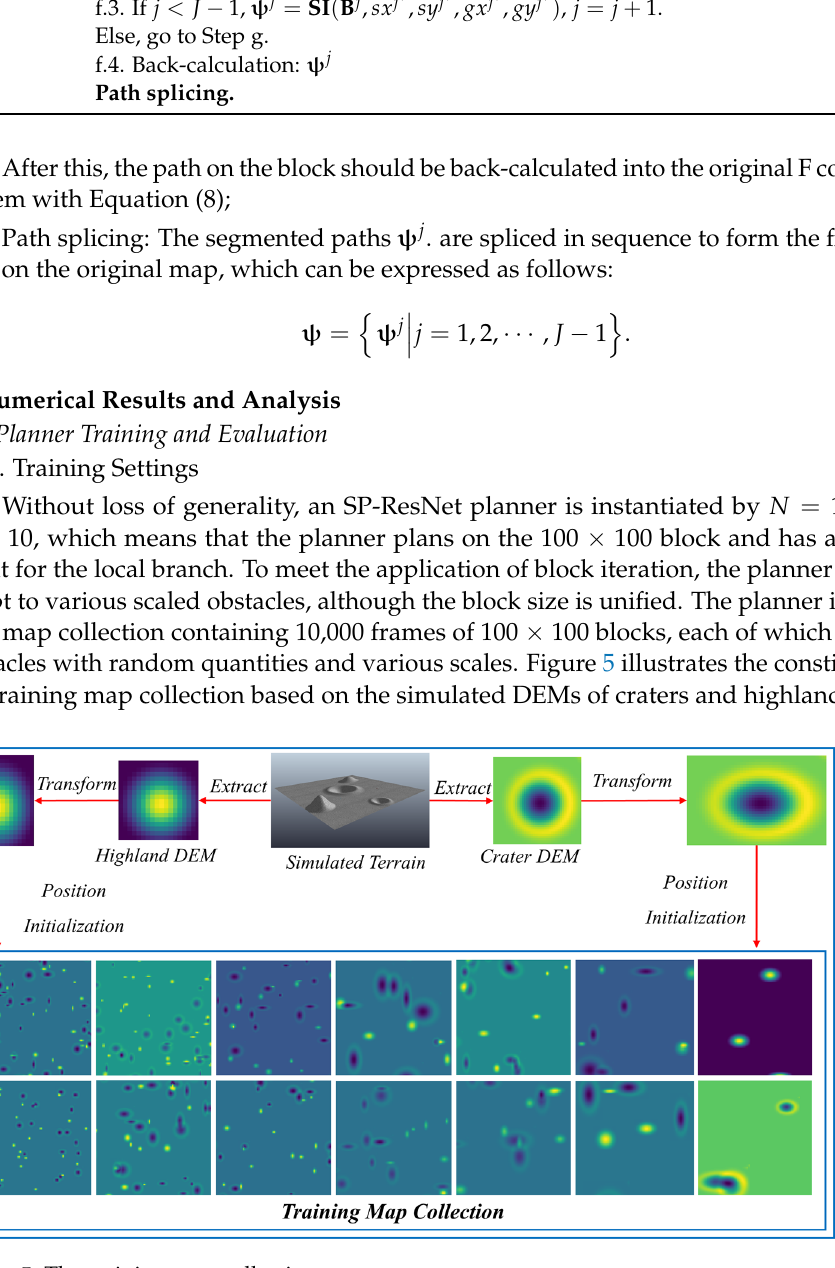
Figure 5. The training map collection.